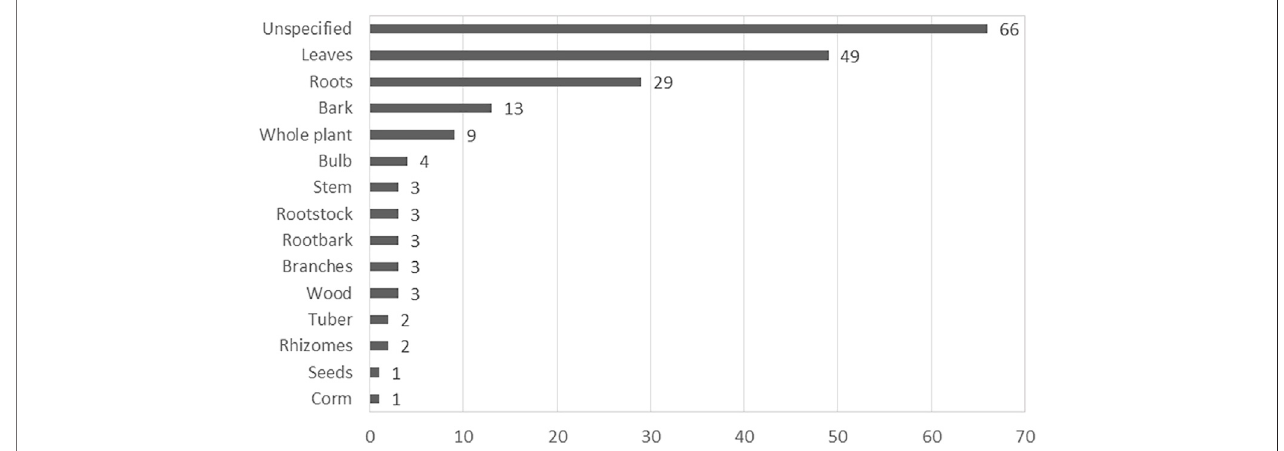
FIGURE 2 | The frequency of medicinal plant parts used in South Africa for depression and related ailments.